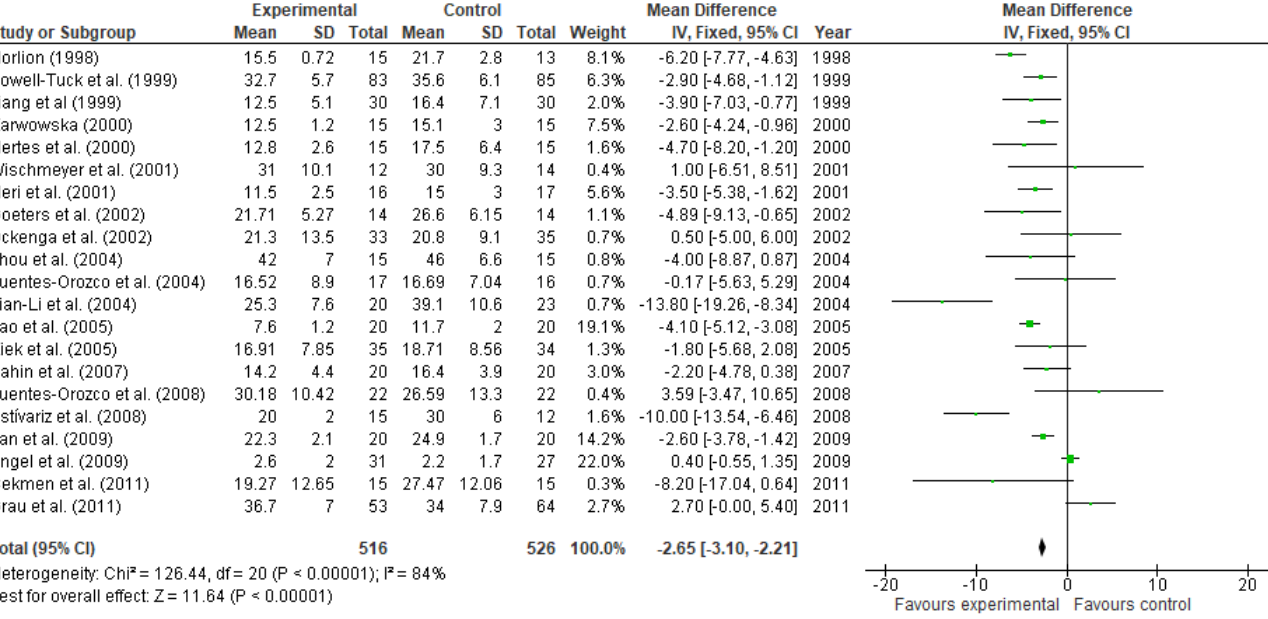
Figure 10. Length of hospital stay: fixed-effects meta-analysis and forest plot from studies providing supplementation of glutamine.